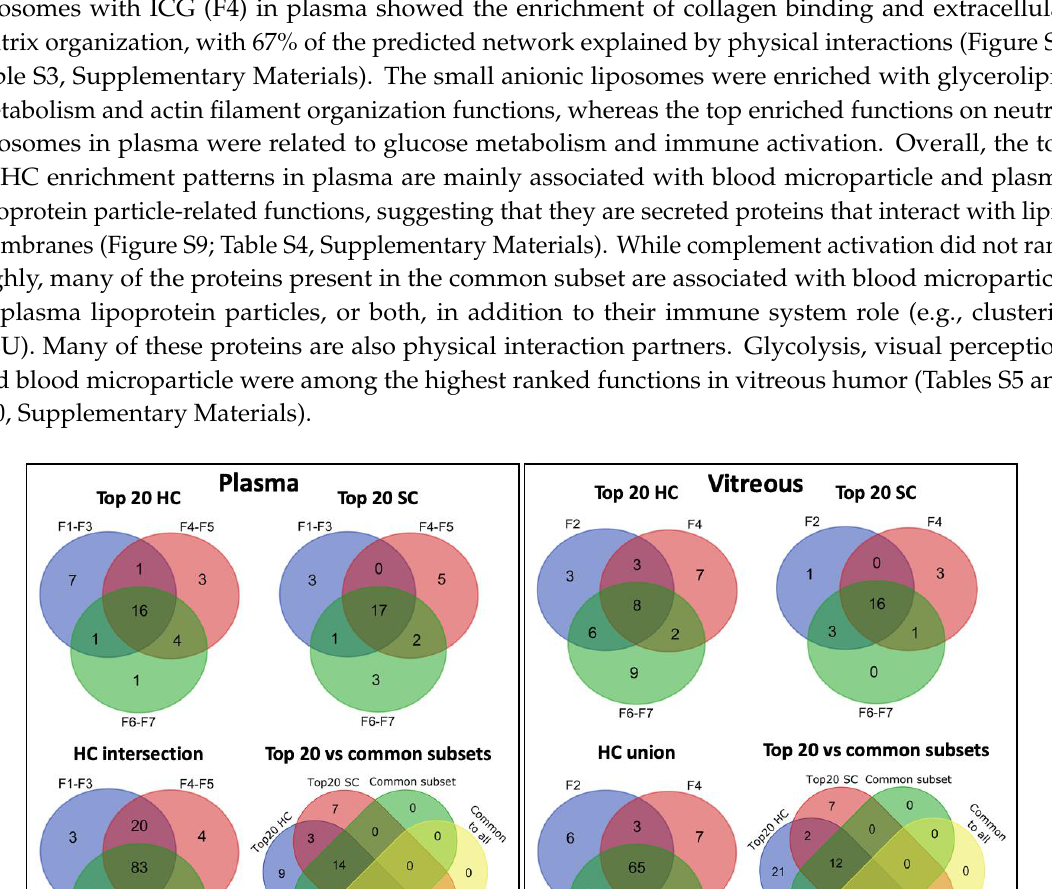
Table 2. Comparison of the vitreal diffusion of HA-coated, PEG-coated, and uncoated liposome formulations. D v was obtained experimentally by single-particle tracking for 1 s, and the D w was calculated based on the Stoke–Einstein equation ( N = 3). * Data from Reference [29]. Formulation